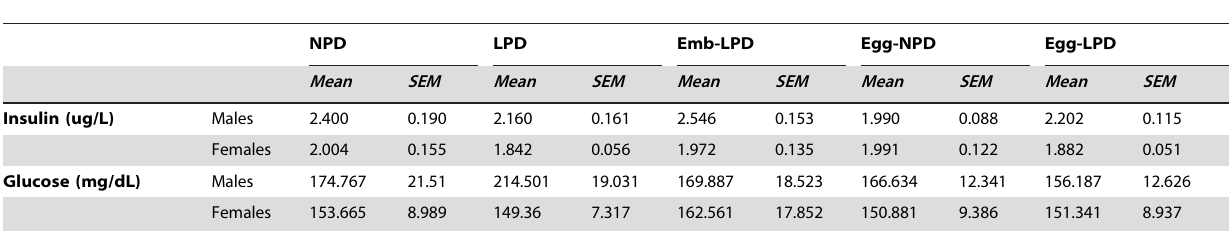
Table 6. Fasted offspring serum insulin and glucose